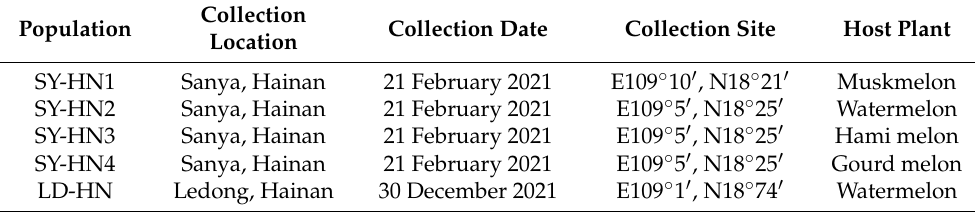
Table 1. Background information on the field populations of T. urticae collected in Hainan,